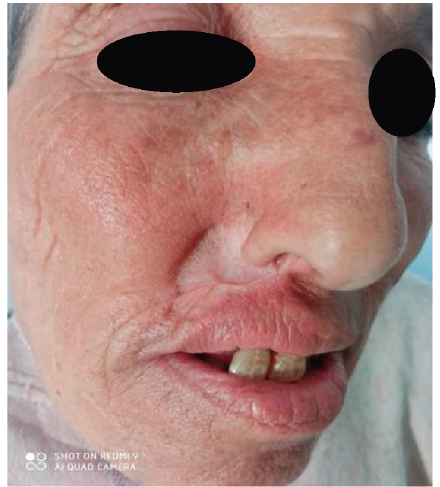
Figure 4: Complete healing of the lesion three months after the last chemotherapy